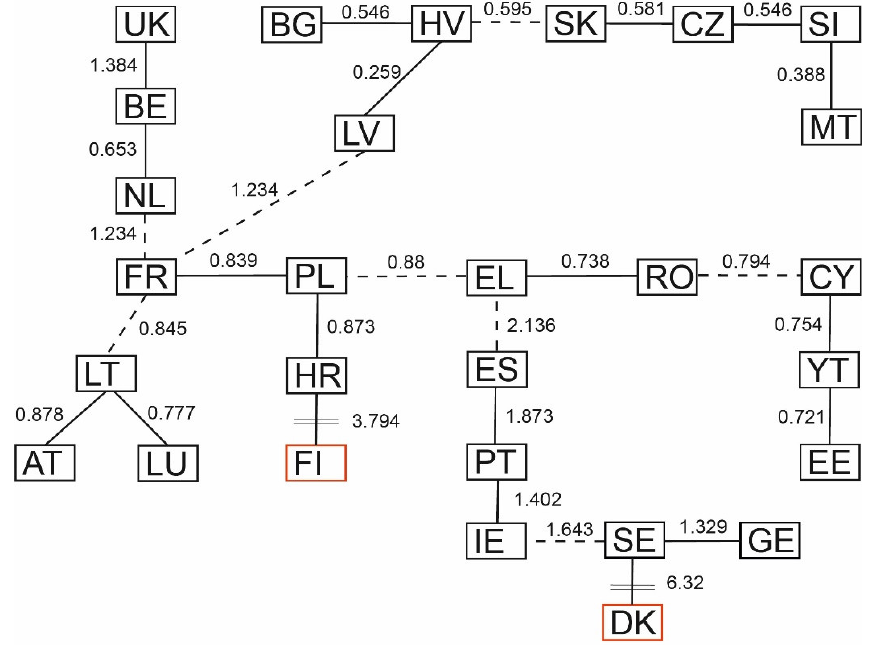
Figure 5. The Wroclaw dendrite—division of countries into clusters.